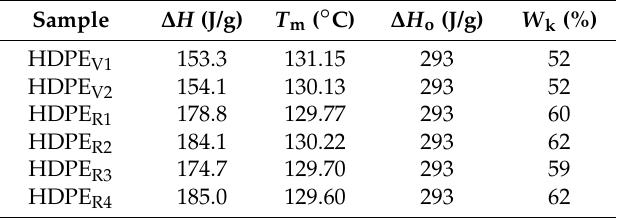
Table 3. Differential scanning calorimetry (DSC) results for new (virgin-V) geogrid samples and aged (Radiowo-R) geogrid samples. ∆ H : melting enthalpy; T m : melting point; W k : degree of crystallinity.